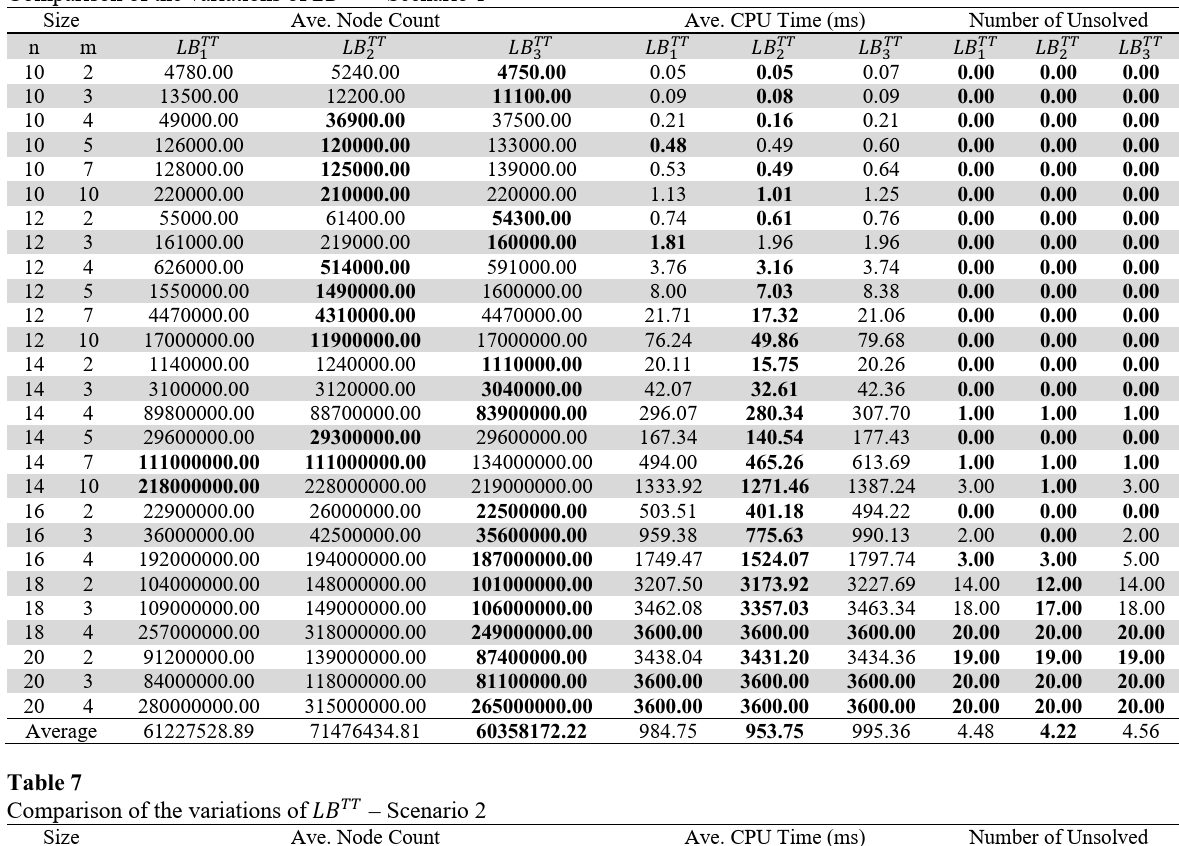
Table 7 Comparison of the variations of 𝐿𝐵 (cid:3021)(cid:3021) – Scenario 2 Size Ave. Node Count Ave. CPU Time